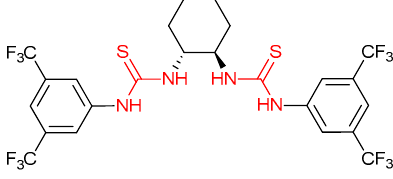
Figure 11. A chiral bis-thiourea prepared by Nagasawa and co-workers [173].